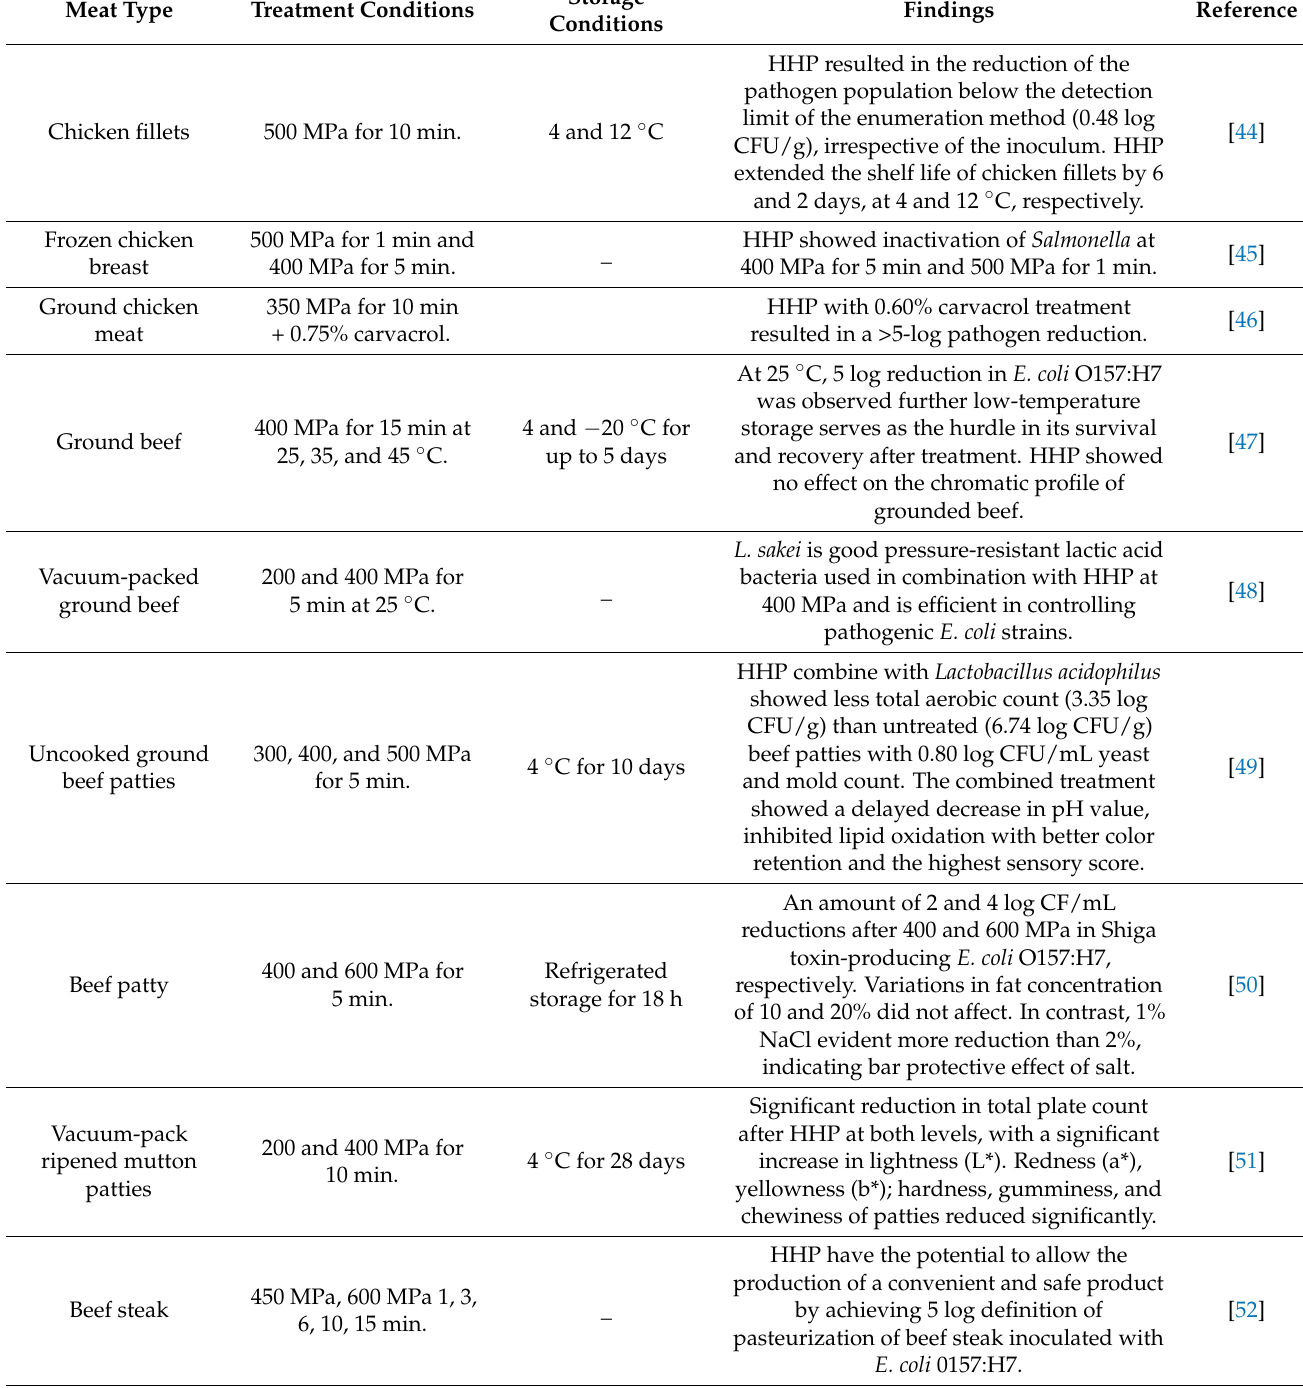
Table 2. HHP applications to decontaminate meat and meat